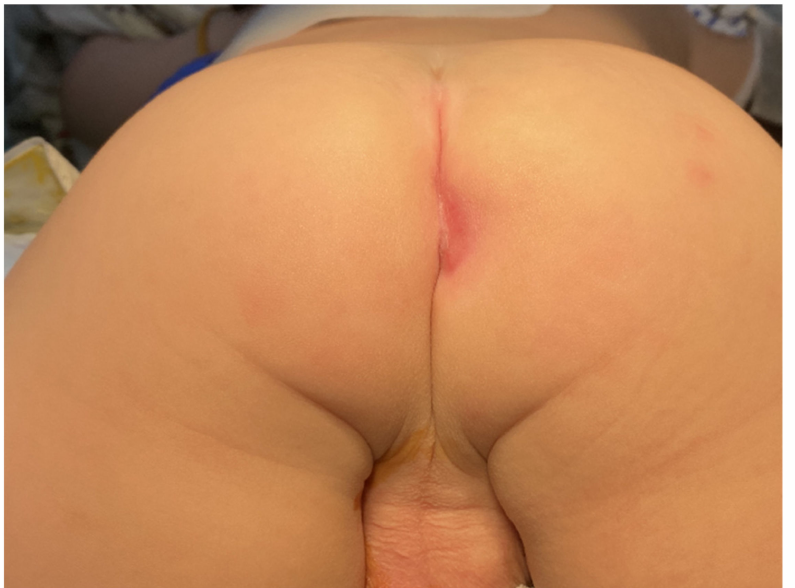
Figure 3. After stopping anal dilator use, the patient’s perianal wound healed well and led to the formation of imperforate